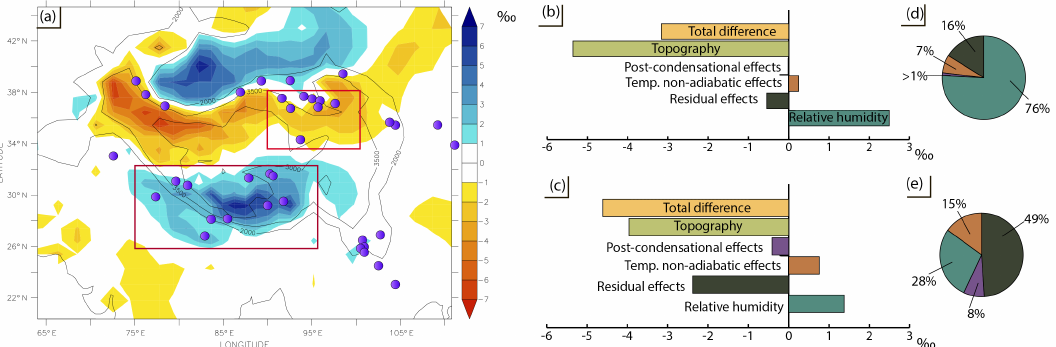
Figure 13. (a) Difference in δ 18 O p between MOD and INT experiments that is not related to direct effect of topography changes. Violet points show Cenozoic palaeoelevation study locations (compiled from Caves et al., 2015). Red rectangles show regions for that averaged values decomposed terms are shown: (b) northern region, (c) southern region. Pie diagrams show portion of total isotopic difference related to processes other then topography: (d) northern region, (e) southern